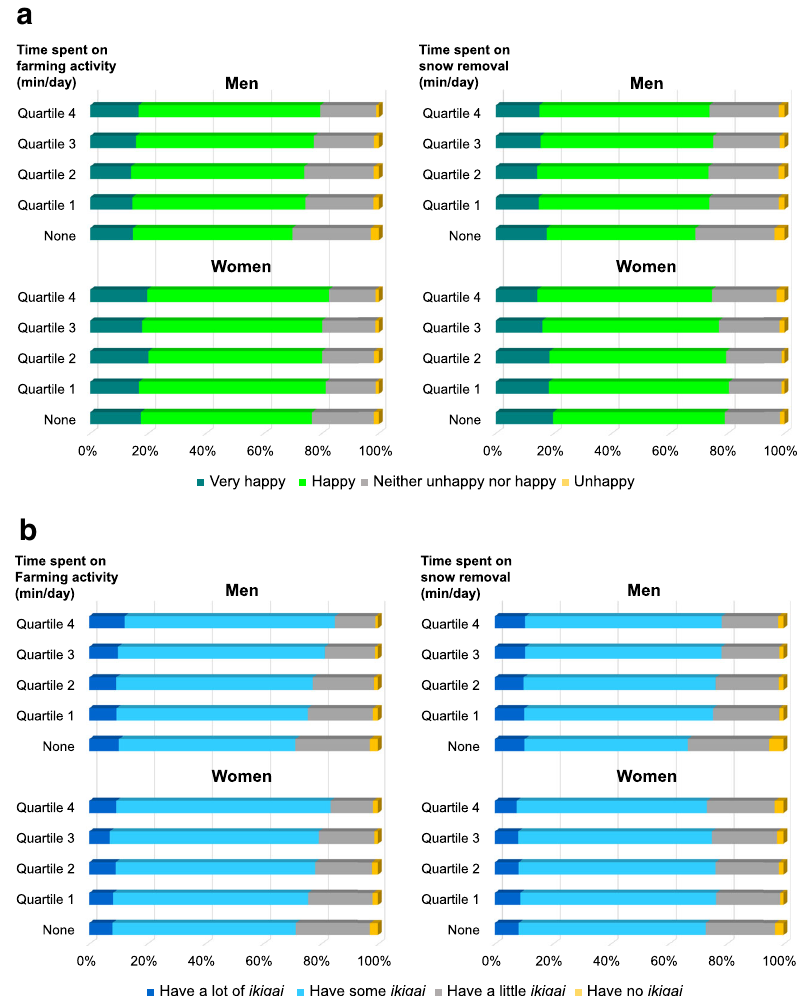
Fig. 3 Distribution of happiness and ikigai according to quartile of each physical activity in rural life. Distribution of happiness ( a ) and ikigai ( b ) according to quartile of time spent on farming activity and snow removal, by